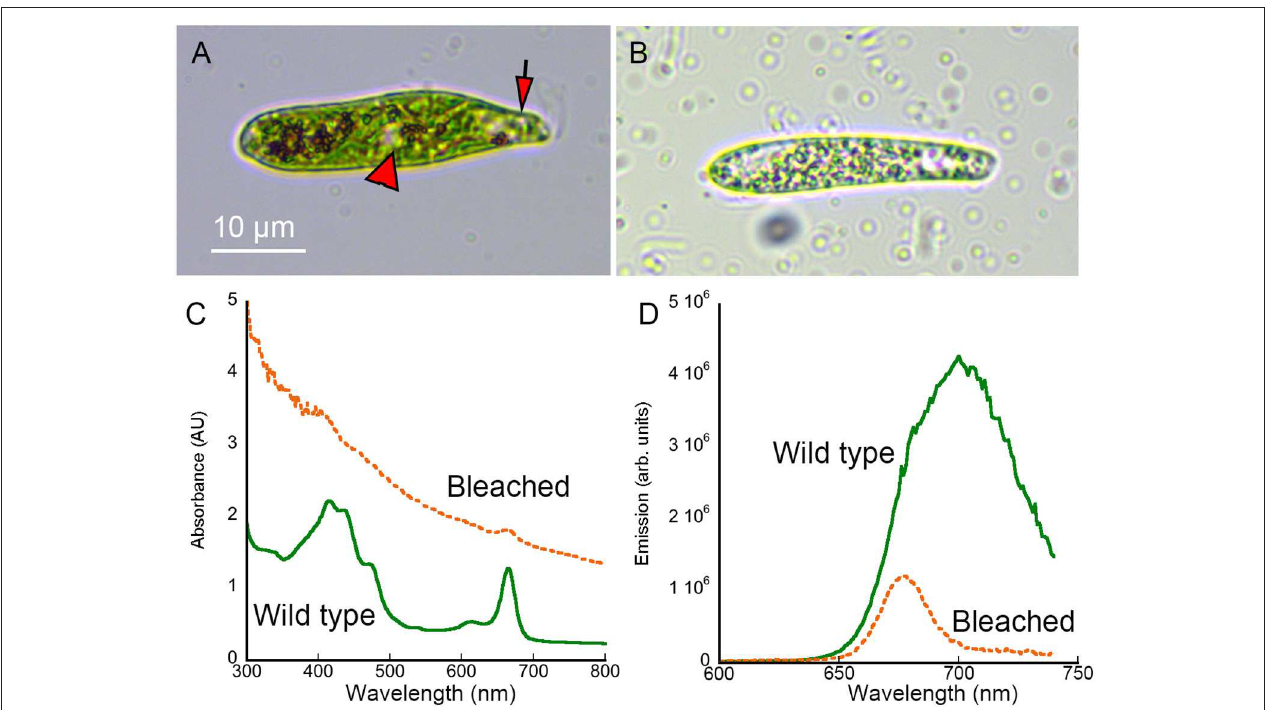
FIGURE 2 | Brightfield images and absorbance and fluorescence spectra of wild-type and streptomycin-bleached Euglena gracilis . Scale bar applies to both panels. (A) Wild-type Euglena showing the eyespot (arrow) and nucleus (arrowhead). (B) Streptomycin-bleached Euglena . (C) Absorbance spectrum of wild type vs. bleached Euglena in methanol. (D) Emission spectrum (excitation 400nm) of wild-type vs. bleached Euglena in